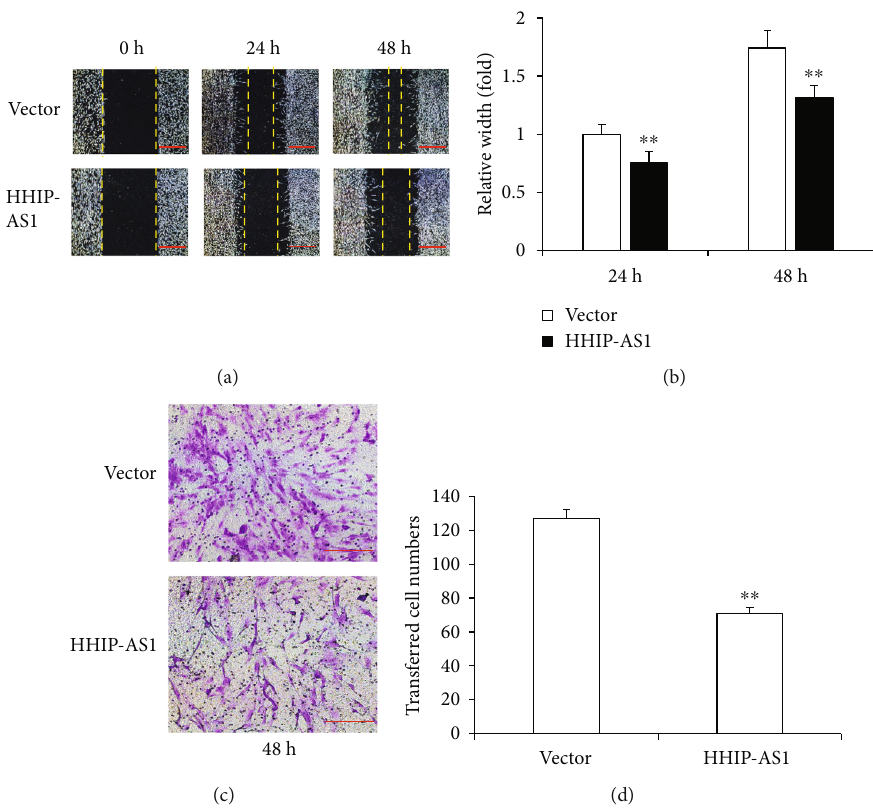
Figure 4: HHIP-AS1 overexpression inhibited the migration and chemotaxis abilities of PDLSCs. The results of the (a) scratch migration assay and (b) quantitative analysis at 24 and 48h (scale bars: 1mm). The results of the (c) transwell chemotaxis assay and (d) quantitative analysis at 48 h (scale bars: 200 μ m). Student ’ s t -test was performed to determine statistical signi fi cance. All error bars represent the SD ( n = 9 ). ∗∗ P ≤ 0 : 01